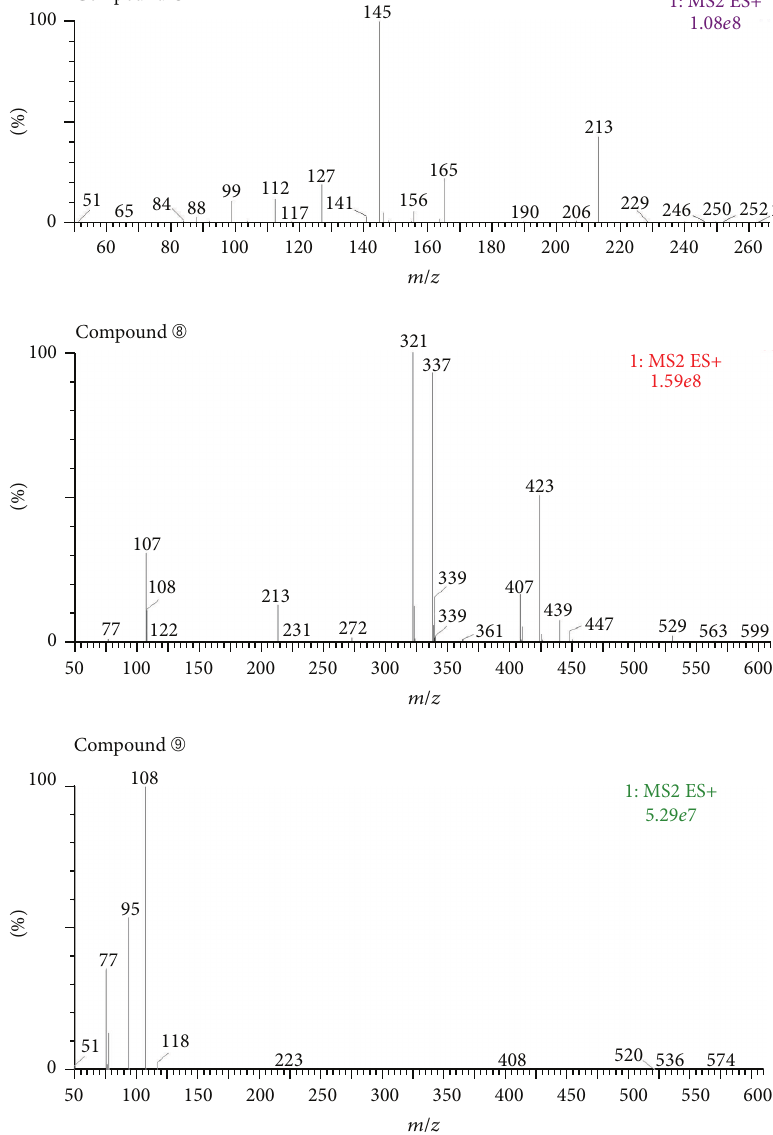
Figure 5: Representative MS spectra of the unknown compounds B , H , and 0